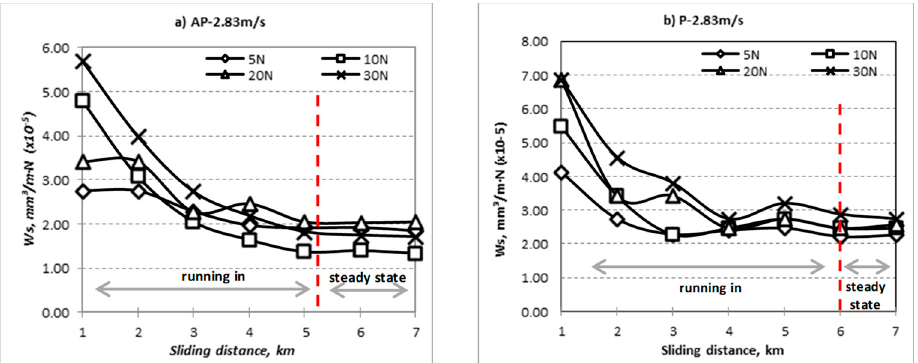
Figure 4. Specific wear rate vs. sliding distance for different fibre orientation (AP and P) subjected to difference of applied normal load at 1.7 m/s of sliding velocity.